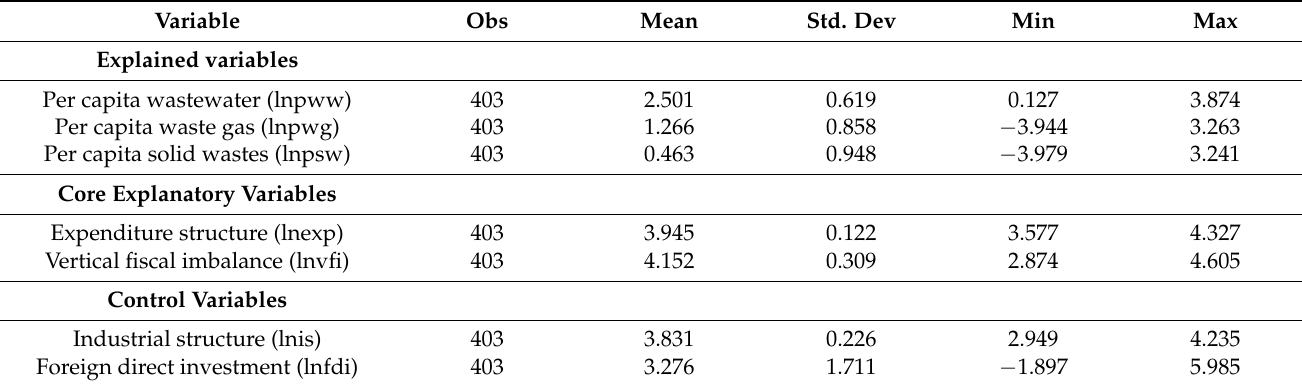
Table 3. Descriptive statistics of main